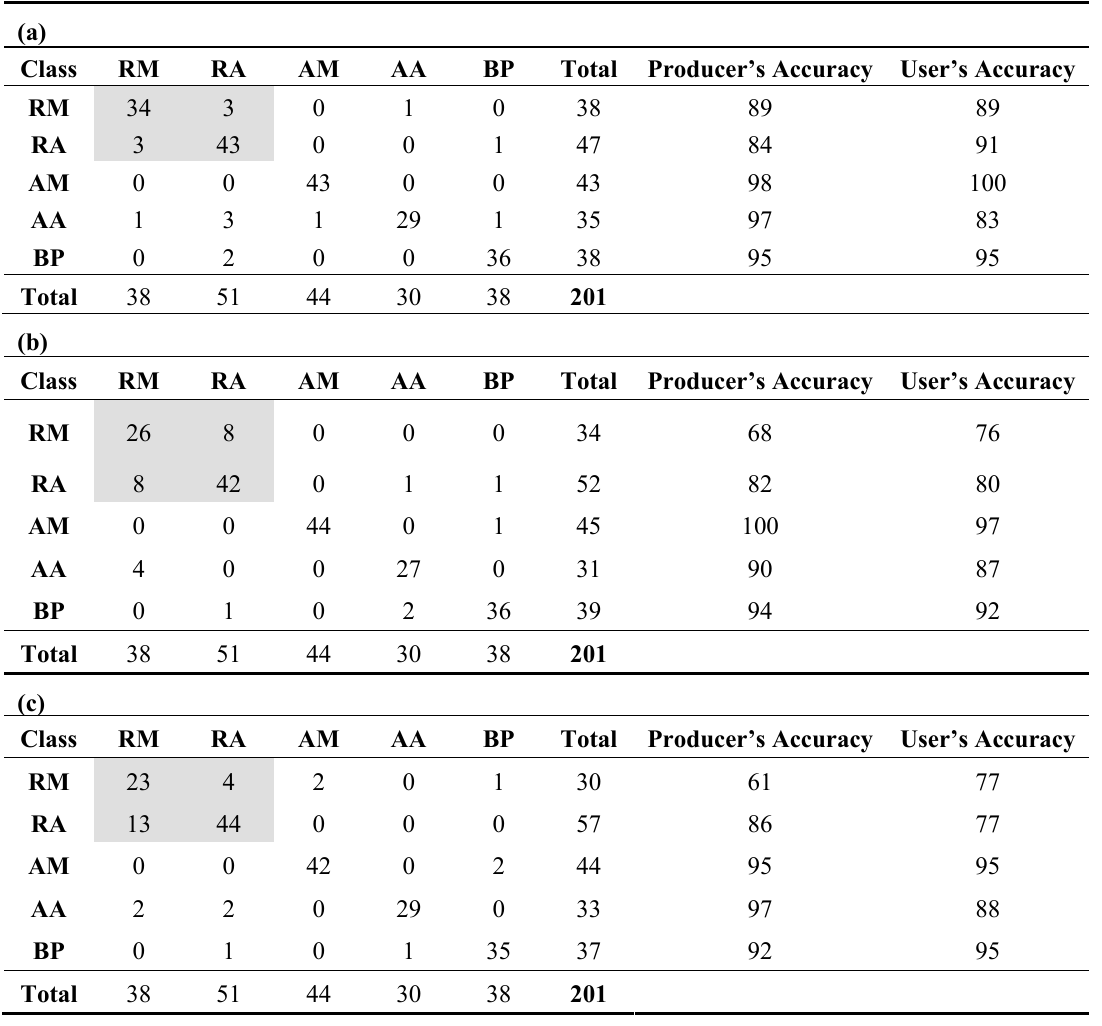
Table 3. ( a ) The confusion matrix, producer’s and user’s accuracy of the winning chromosome selected by the genetic search algorithm (Overall Accuracy = 92%), ( b ) The confusion matrix, producer’s and user’s accuracy of the band combination selected by the SFS feature selector (Overall Accuracy = 87%), and ( c ) The confusion matrix, producer’s and user’s accuracy of the all-spectral-band combination (Overall Accuracy =